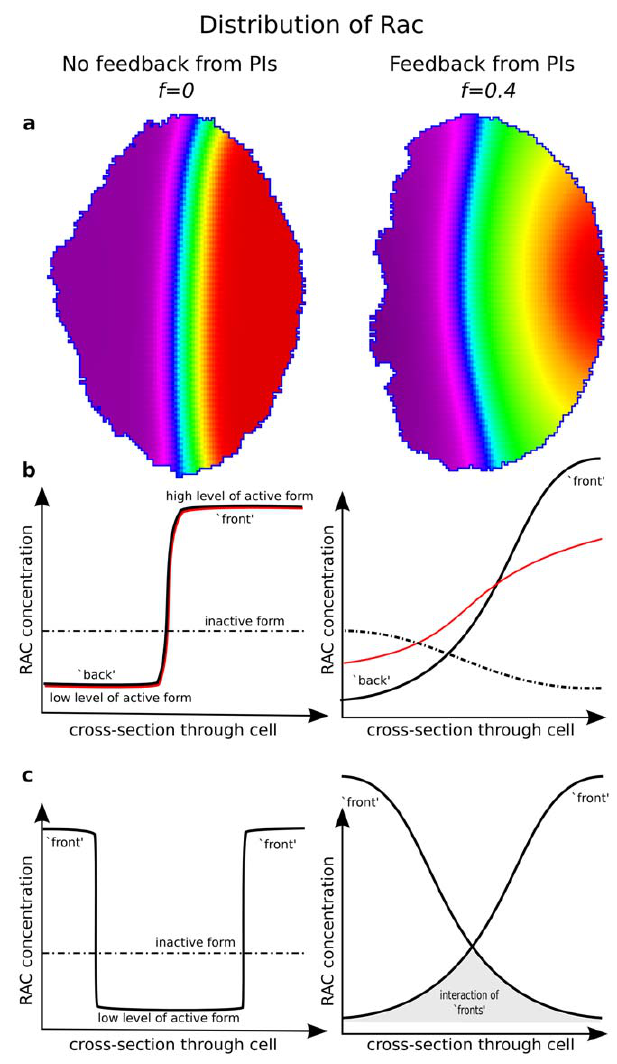
Figure 3. Schematics of how feedback from PIs change small GTPase profiles. Shown are the Rac distributions in the 2D cell [( a ) and Video S1] and in a representative 1D cross-section along the cell diameter ( b,c ). Left panels: absent PI feedback ( f ~ 0 ). Right panels: with PI feedback ( f ~ 0 : 4 ). The sharp transition between high and low Rac activity is seen on the left (contours closely spaced), whereas PIs create a broader transition zone (right). Panels (b–c): schematics of differences in intracellular patterns due to maximal PI feedback to Rho proteins. (b): Inactive Rac (dot-dashed line) is nearly uniform for f ~ 0 , but shows significant depletion close to the ‘‘front’’ for high f . Decreasing the rate of diffusion D mc of inactive Rac (red curves) has little effect on the profile when f ~ 0 . In contrast, decreasing D mc when f ^ 0 : 4 leads to a lower peak of active Rac at the front. Panels (c): Communication of multiple peaks of active Rac is very slow in the f ~ 0 case, and much more significant in the case f ^ 0 : 4 . Hence, feedback from PIs helps to resolve conflicting cell